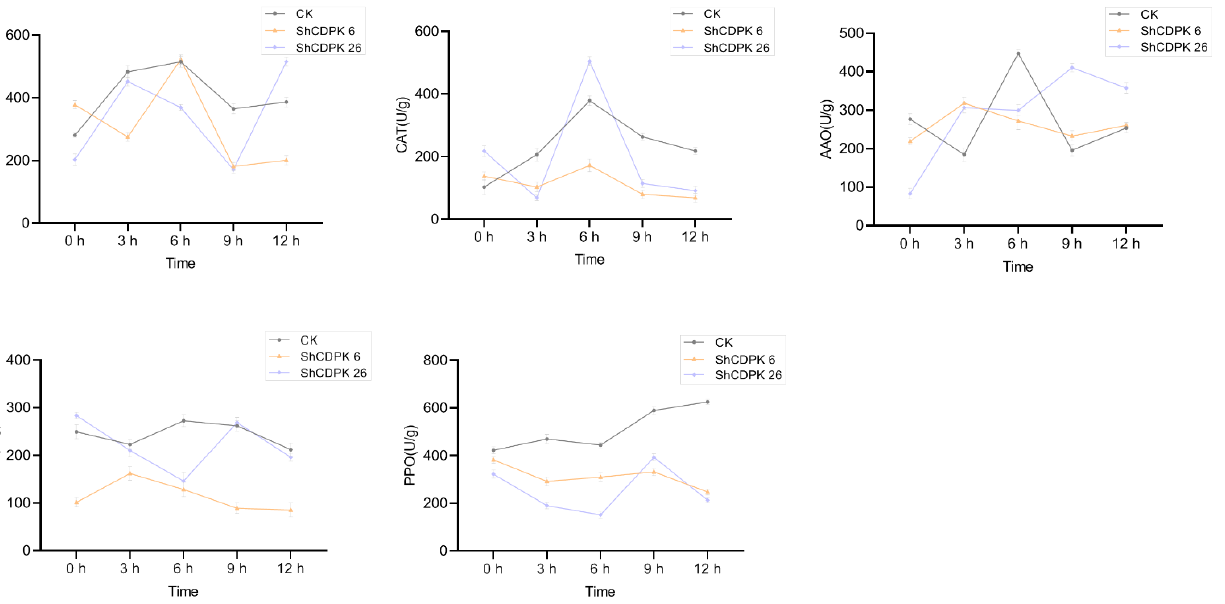
Figure 9. Determination of physiological indexes of ShCDPK6 and ShCDPK26 silenced plants and control plants under Botrytis cinerea stress. Activity of SOD, CAT, AAO, POD, PPO. Each value is the mean ± standard deviation of at least three independent measurements. 3. Discussion The CDPK gene family widely exists in all parts of plants, such as roots, stems, leaves, flowers, fruits, and seeds, and plays an important role in plant state construction [17,34]. Arabidopsis CPK11 positively regulates the ABA signaling pathway in seed germination